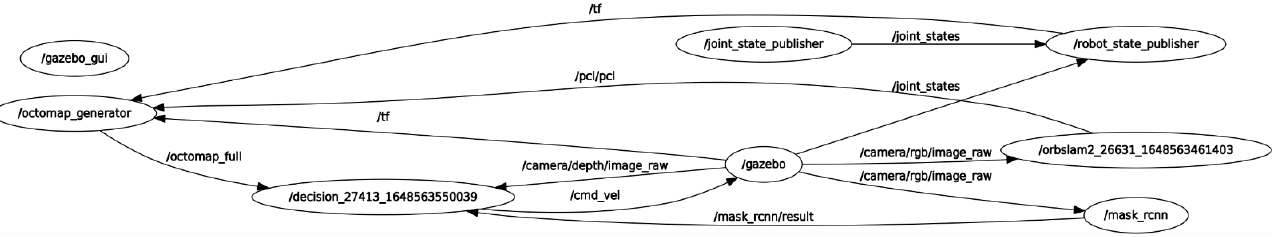
Figure 2. ROS architecture designed in this paper.